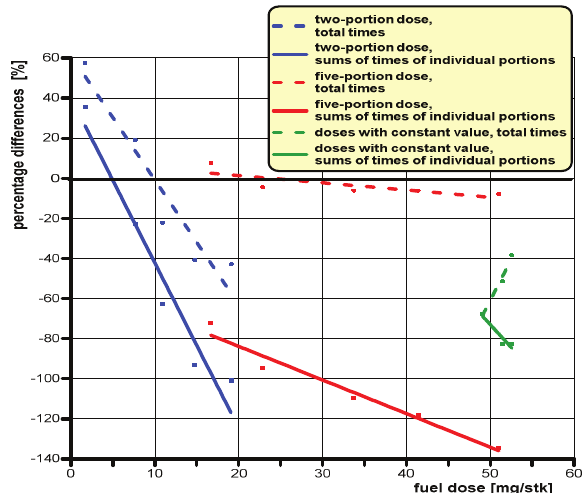
Fig. 9. Percentage differences between preset and calculated injection times, evaluated for two- and five-portion